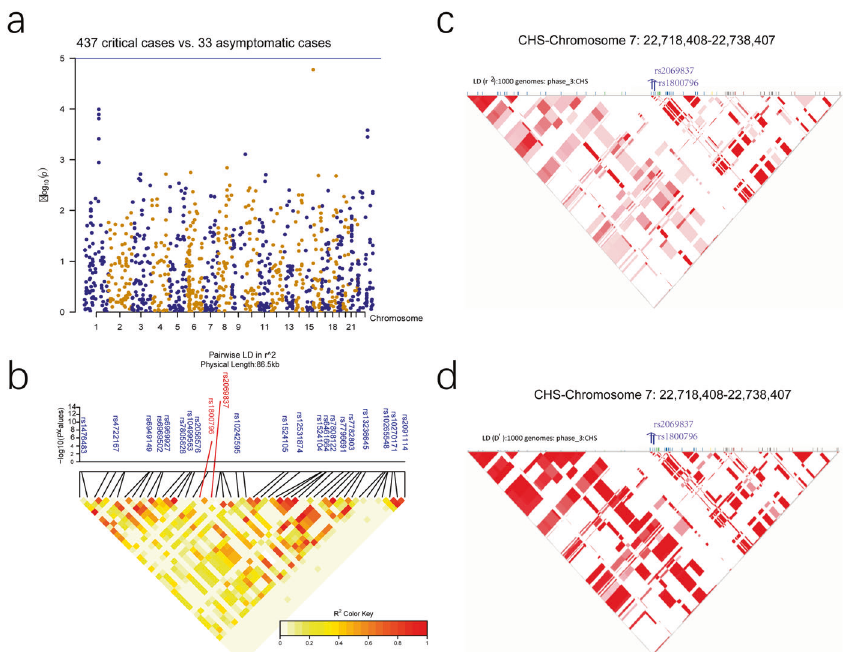
Fig. 2 The association signal of the rs2069837 LD. a No loci surpassed genome-wide signi fi cance ( P < 5 × 10 − 8 ) between the 437 critical and the 33 asymptomatic cases in the discovery stage of GWAS. b Linkage disequilibrium (LD) plot of 85.6 kb of rs2069837 association with COVID- 19 in our imputed GWAS result. c-d r 2 of LD plot of rs2069837 in 1000 Genomes Southern Han Chinese (CHS) data ( c ) and D ’ of LD plot of rs2069837 in 1000 G CHS data ( d